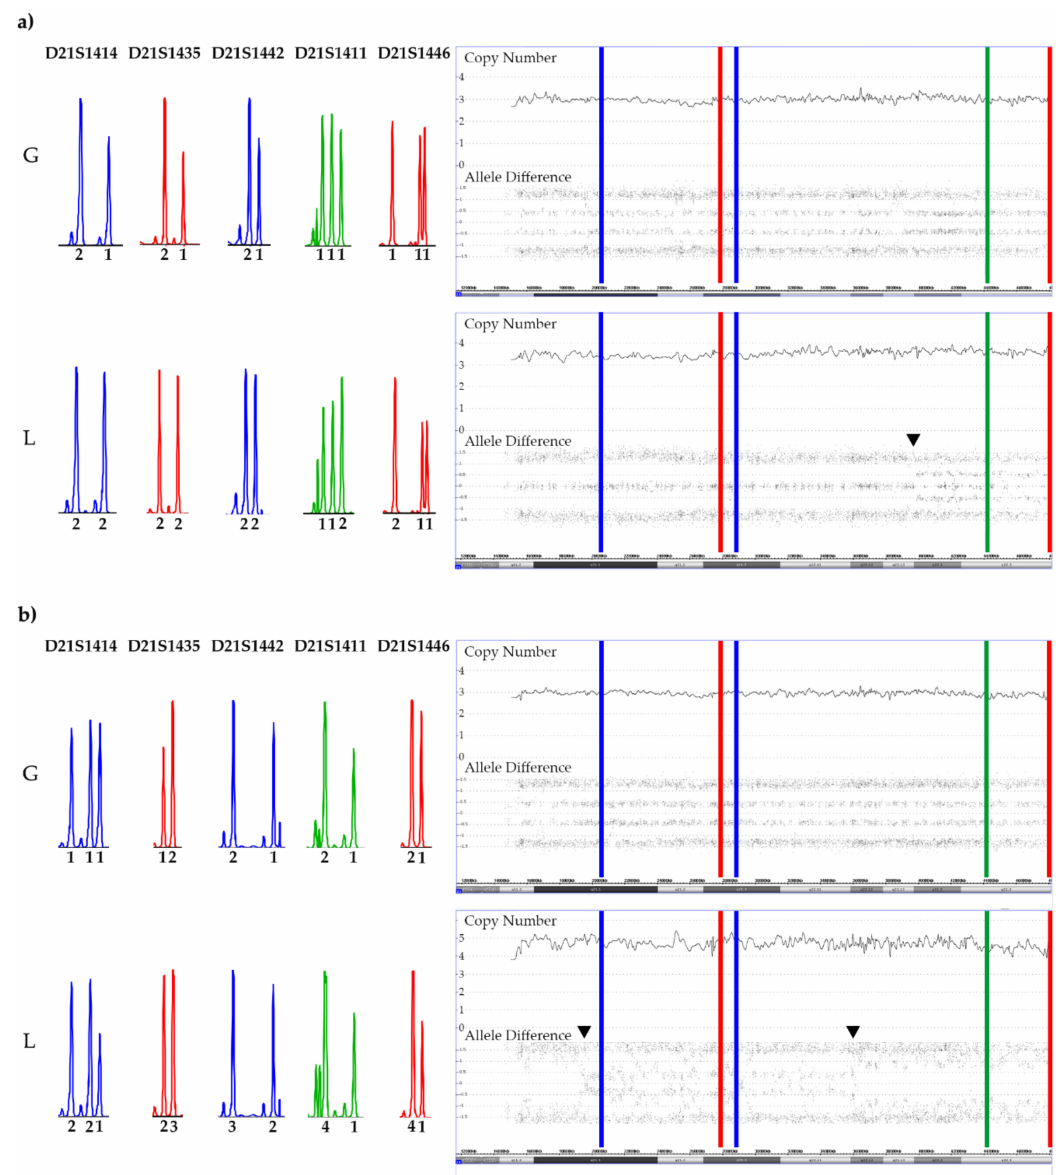
Figure 10. SNP array and STR patterns of the leukemic and remission sample of constitutional trisomic patients with an acquired tetrasomy ( a ) or pentasomy ( b ) of chromosome 21. The corresponding allele copy numbers are indicated below the respective STR markers. As evidenced by the STR markers with three alleles, both cases result from a (most likely maternal) meiosis 1 error. However, without parental material we were unfortunately not able to unequivocally define which parental homologues were indeed gained in the tetra- and pentasomic clones, respectively. In the tetrasomic case ( a ), the first four STR markers on the right and the fifth one on the left define the duplicated chromosome. Moreover, in this example a meiosis 1-associated switch from a “2 + 2” to a “2 + 1 + 1” configuration uncovered a recombination site that is clearly visible in the array-derived allele distribution pattern, and which is incidentally located in the ERG gene (indicated by the black arrow). Copy number validation with a RUNX1 FISH probe identified a trisomy in 21% and a tetrasomy in 79% of the leukemic cells. The situation is similar in the pentasomic case ( b ), in which two of the four STR markers with homozygous alleles (“2 + 1”; D21S1435, D21S1442, D21S1411and D21S1446), which might have been either uniparental or biparental-derived, became duplicated (D21S1411and D21S1446) together with two of the three D21S1414 and one each of the D21S1435, D21S1442 markers. There are two meiotic recombination sites, which in this instance resulted from a “4 + 1” to a”2 + 3” and again a “4 + 1” allele distribution switch (indicated by the black arrows). Copy number validation with a RUNX1 FISH probe identified a trisomy in 29% and a difficult to discriminate tetra- or pentasomy in 71% of the leukemic cells. We found such recombination sites in two of the three tetrasomic and in two of the four pentasomic